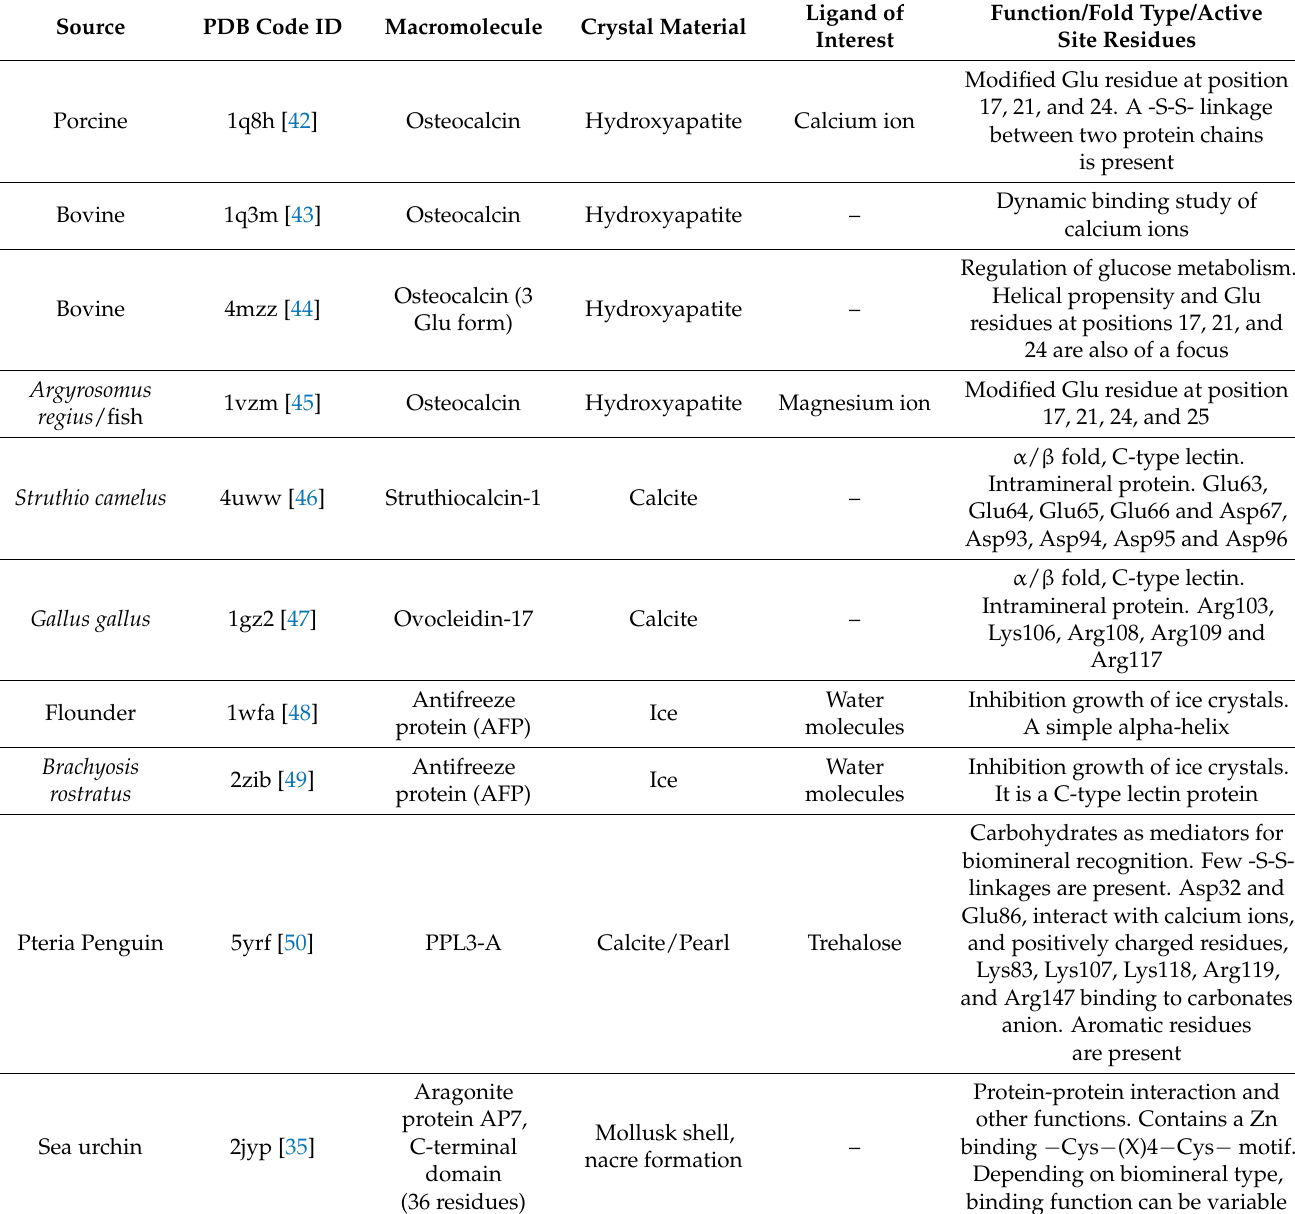
Table 1. Natural, designed, and re-engineered proteins for the synthesis of functional biominerals. The unique entries are retrieved from the RCSB PDB (RCSB.org) [31,40]. The 3D structure for